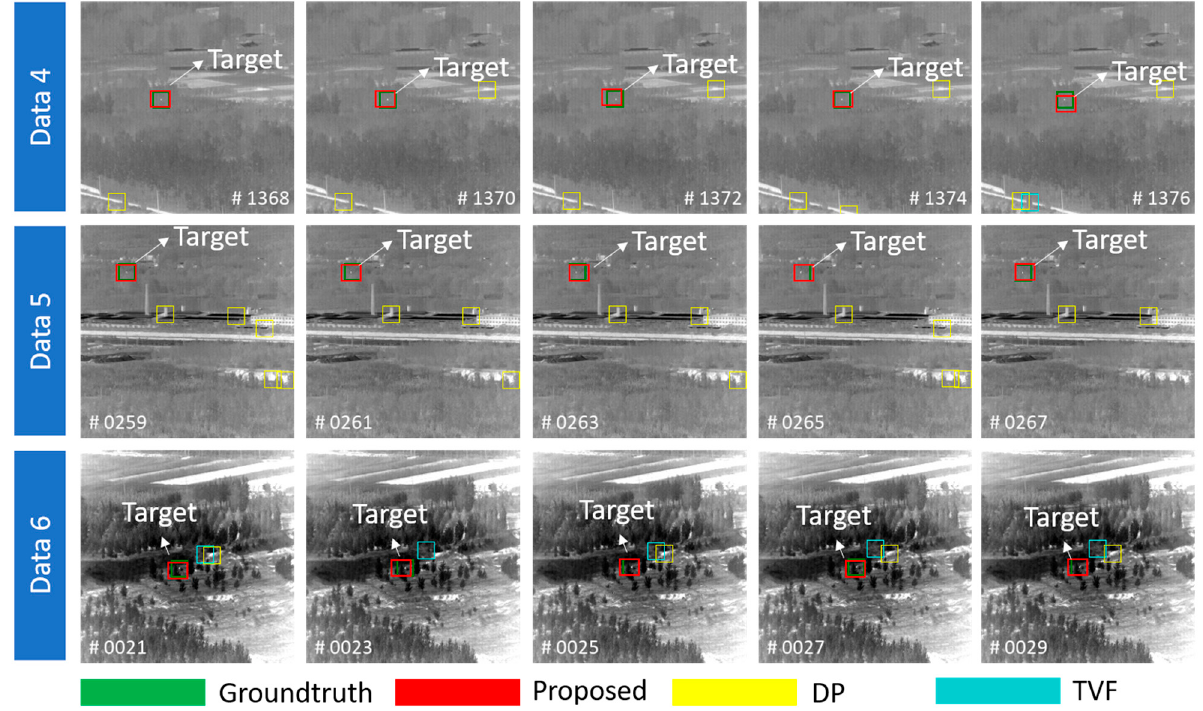
Figure 16. Detection results between our method and traditional multiple-frame-based methods in public datasets. The target has been marked by texts, and the other prediction boxes are false alarms. Experimental results show that only the method in this paper achieves continuous detections.